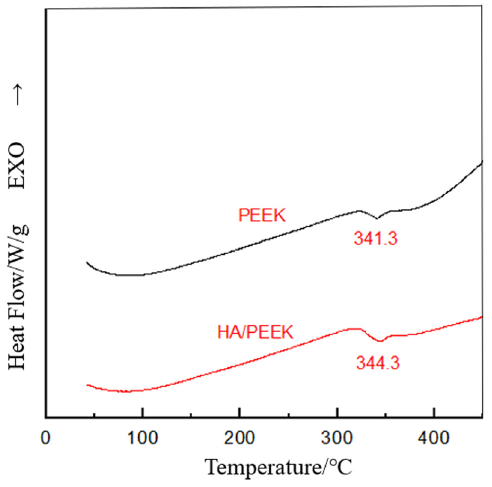
Figure 4: DSC curves of pure PEEK and HA/PEEK nanocomposite ( containing 2.5 wt% - modi fi ed HA )